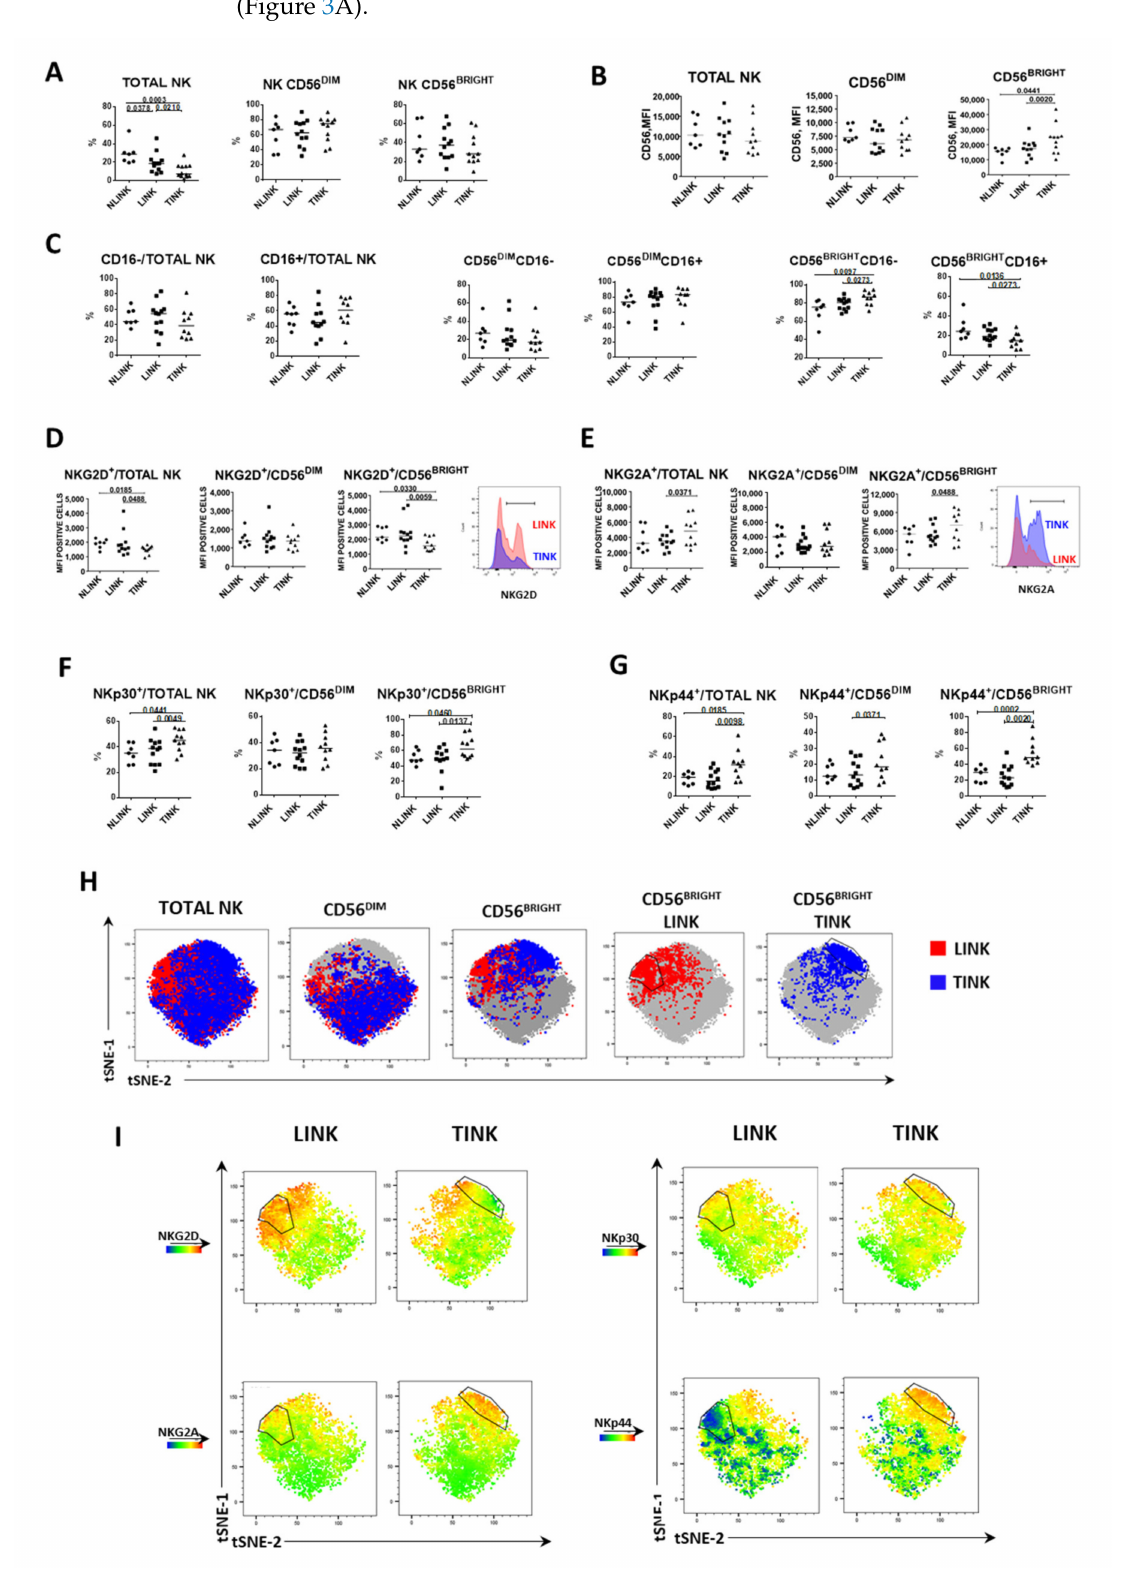
Figure 1. Frequency and phenotype of natural killer (NK) cells infiltrating normal liver tissue (NLINK), HCC-surrounding liver (LINK), and HCC (TINK). ( A ). Frequency of total NK cells and CD56 DIM and CD56 BRIGHT subpopulations in NLINK (n. 7), LINK (n. 12), and TINK (n. 12). ( B ). Median fluorescence intensity (MFI) of CD56 expression in NK cell subsets (total